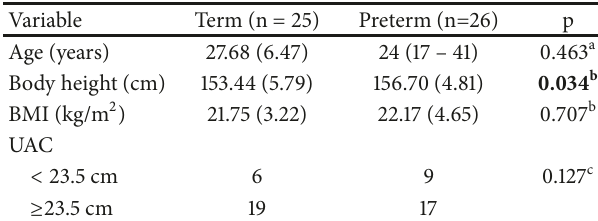
Table 1: Characteristics of